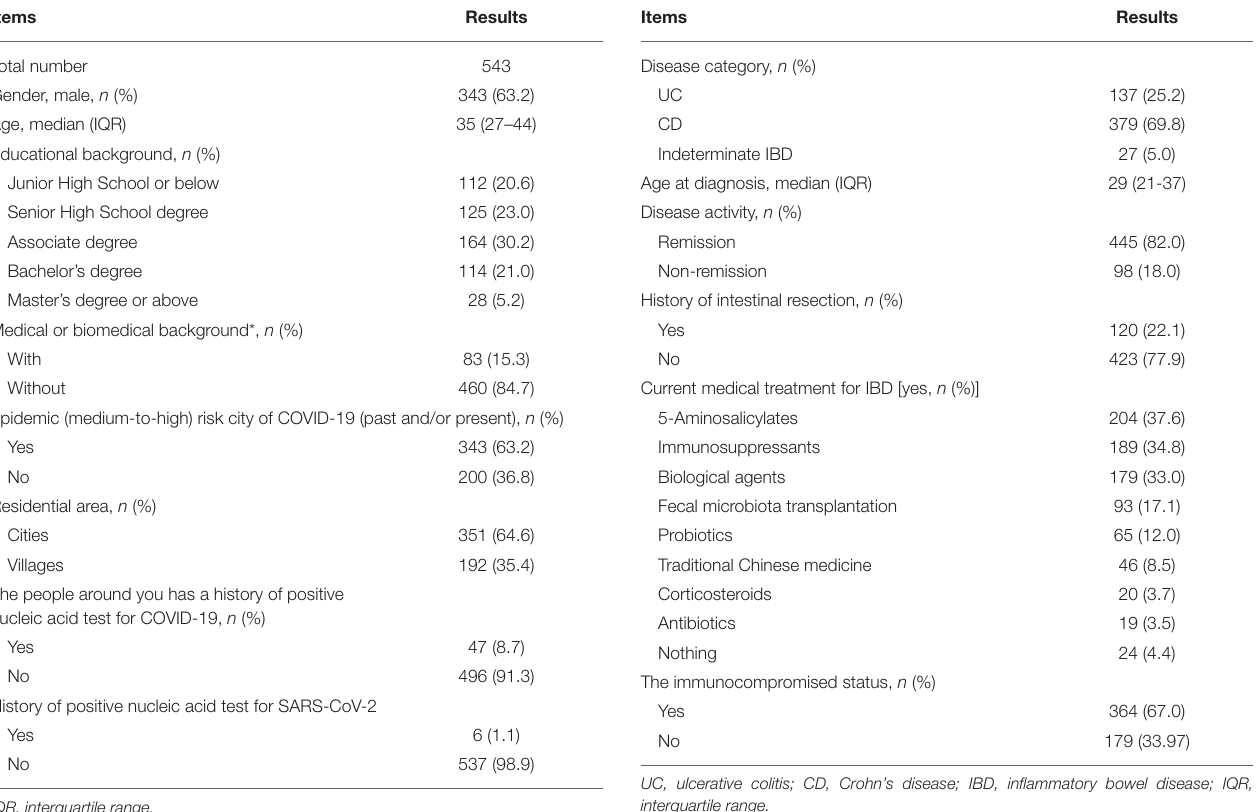
TABLE 1 | The demographics of participants and their exposure to COVID-19. TABLE 2 | Characteristics and medications for patients with IBD at